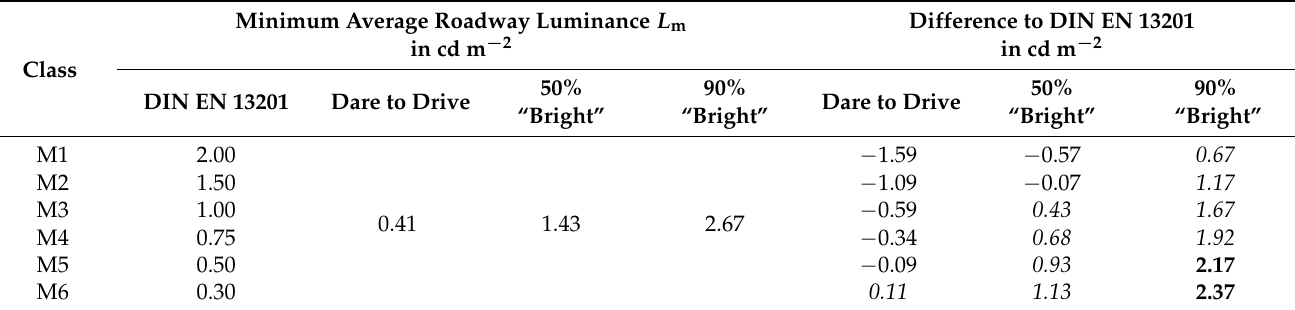
Table 6. Differences determined for achieving the minimum required and preferred roadway luminance values at a velocity of 50kmh − 1 . The determined differences (columns 6–8) show that for the majority of lighting classes (column 1), a combi- nation of street lighting and dimmed headlights is sufficient to provide the preferred roadway luminance (columns